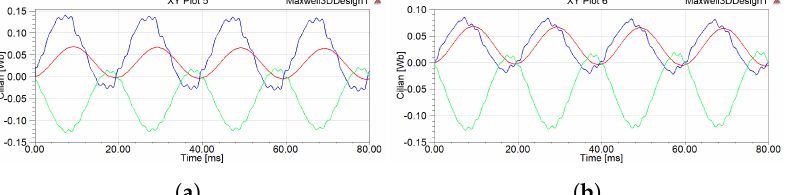
Figure 14. Waveforms of flux linkage from the three windings under working condition 2. ( a ) The left column. ( b ) The right column.